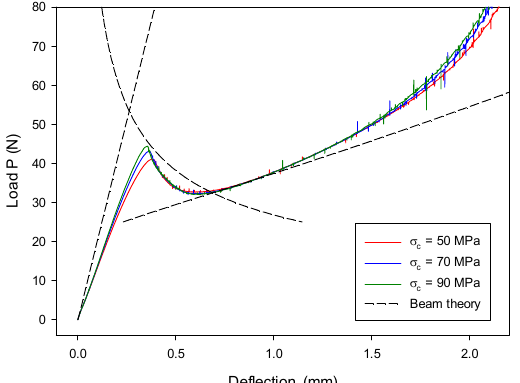
Figure 24. End load P as a function of deflection ∆ in the MMB model ( β = 50%) with different cohesive strengths.